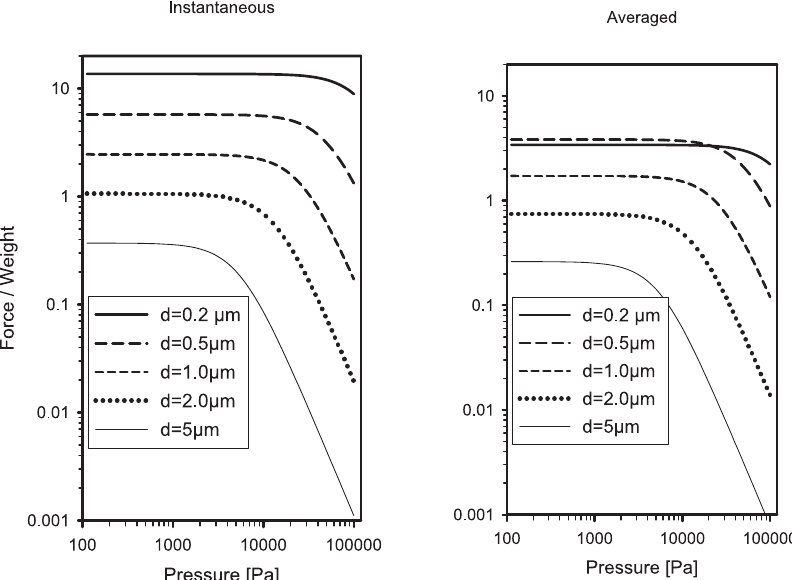
Fig. 8 Photophoretic Δ α force as a function of pressure for various particle sizes. The force is given relative to the weight of the particle. Left side: Force on a particle, which is assumed to be fixed in space. Right side: average force for a particle oriented by a magnetic field, but disturbed by Brownian